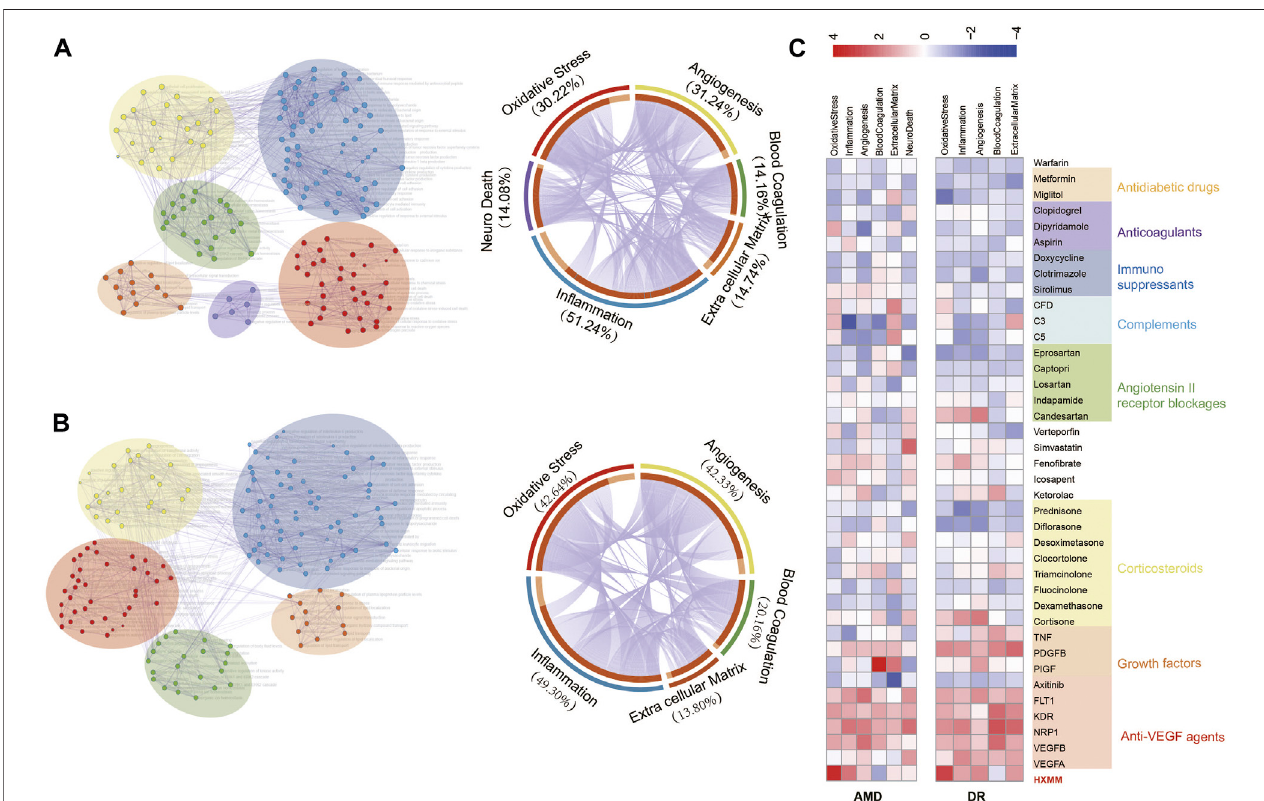
FIGURE 2 | Major pathological process of AMD (A) and DR (B) and FDA-approved-drug disturbance on these pathological process subnetworks (C) . (A,B) Network of enriched biological process GO terms of AMD and DR (left), GO terms clustered in one group were marked with the same color (red — oxidative stress, blue — in fl ammation, yellow — angiogenesis, green — blood coagulation, organ — extracellular matrix, and purple — neuro death). Node size changes with the count of genes in this GO term. The circos plot of genes in GO terms cluster group shows the overlapping of major pathological processes. (C) FDA-approved-drug disturbance on these pathological process subnetworks. Anti-VEGF agents, growth factors, corticosteroids, angiotensin II receptor blockers, complements, immunosuppressants, anticoagulants, antidiabetic drugs were marked by blocks with different colors from red to gray.